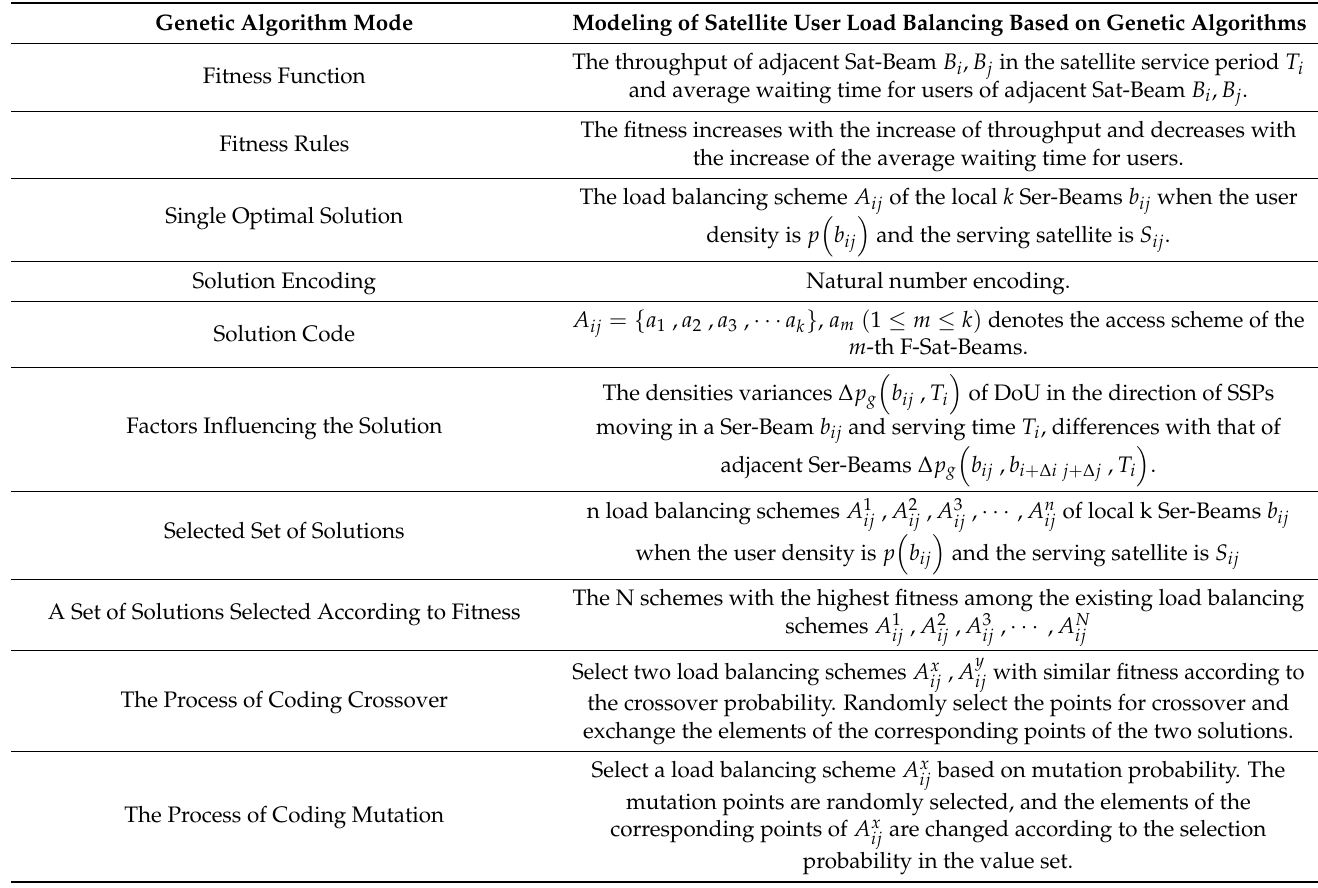
Table 1. The solution modeling of load balancing by